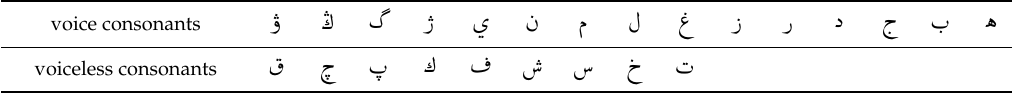
Table 5. Consonants